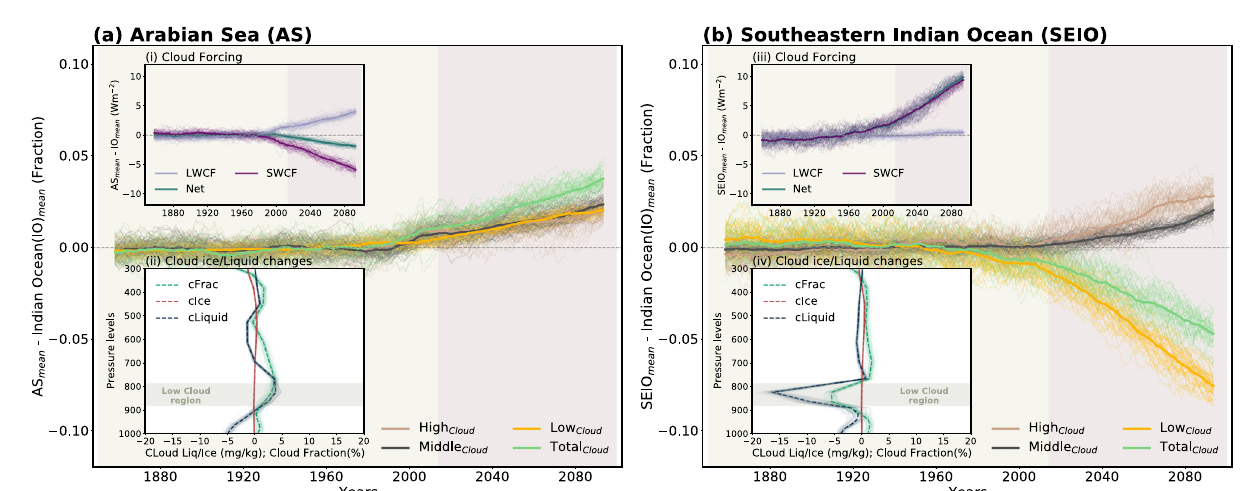
Fig.3|Driversforfuturechangesintheradiativeheat fl uxovertheArabianSea (AS) and Southeastern Indian Ocean (SEIO). Time series of vertically integrated cloudcoveroverthe a ASfrom1850 – 2100for50ensemblemembers.Insetplot (i) in ( a ) shows the time series of the long-wave cloud forcing (LWCF), short-wave cloudforcing(SWCF),andnet(LWCF+SWCF)cloudforcing,and(ii)representsthe changes in cloud liquid amount, cloud ice amount and cloud fraction over the AS